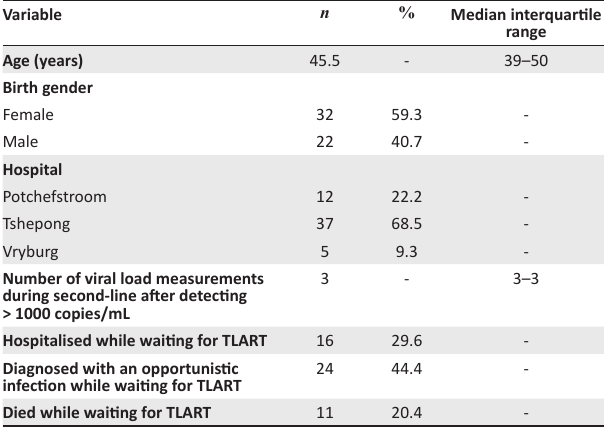
TABLE 1: Baseline characteristics and outcomes of individuals who failed second- line therapy with protease inhibitor resistance in North West, South Africa, 2015–2019.